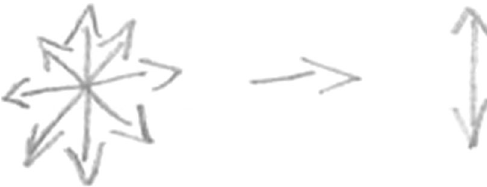
FIG. 5. The drawing of student S06_E. The arrowhead repre- sents the direction of the propagation of